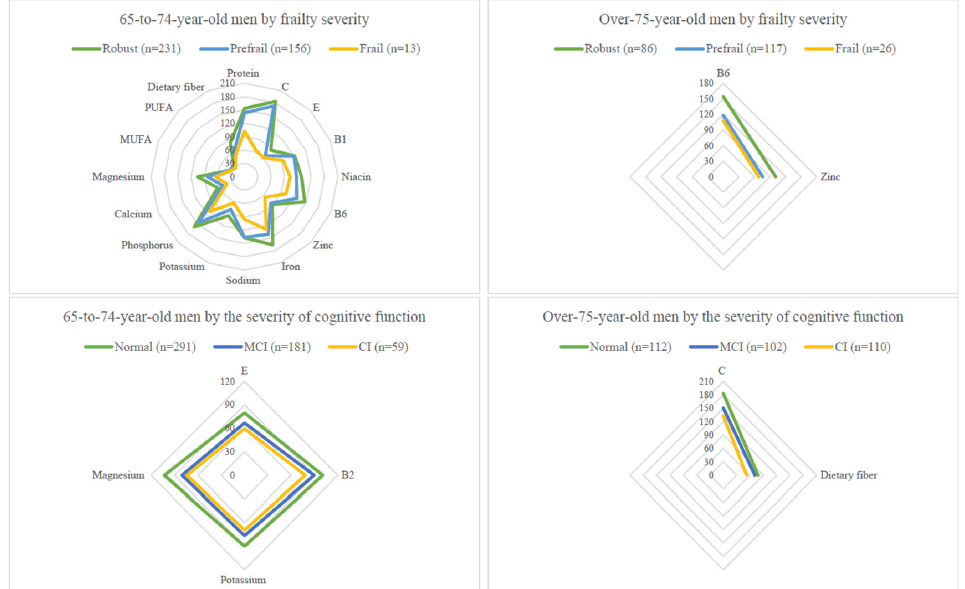
Figure 1 . Comparing nutrient intake levels (presented as % RDA) across geriatric syndrome sub ‐ groups in men. Top: Total energy and nutrients intakes (presented as % RDA) by three frailty sub ‐ groups and by two age groups in men. Bottom: Total energy and nutrients intakes (presented as % RDA) by three CI subgroups and by two age groups in men. The trend test was performed by using the general linear model to test whether the mean of each nutrient variable has an ordered relation ‐ ship across either the three frailty subgroups or three CI subgroups when age was adjusted.